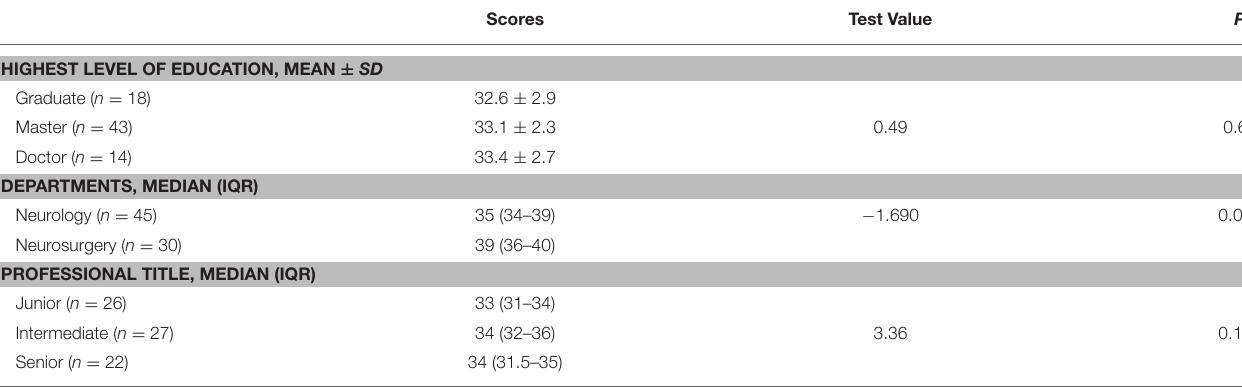
TABLE 6 | Subgroup analyses comparing total scores of participants for each